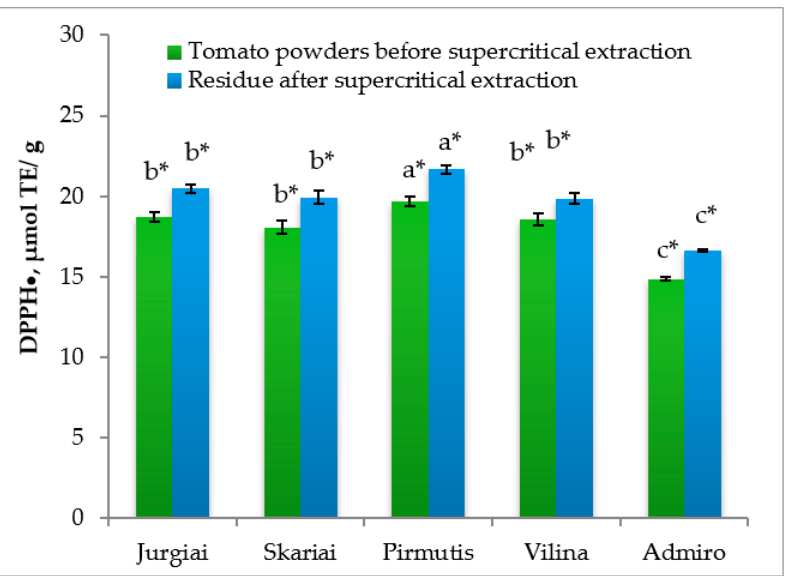
Figure 2. DPPH • radical binding activity in tomato powders and residues after SCE-CO 2 extraction. * Different letters above the columns of the same color indicate significant differences between the measured values ( p ≤ 0.05).